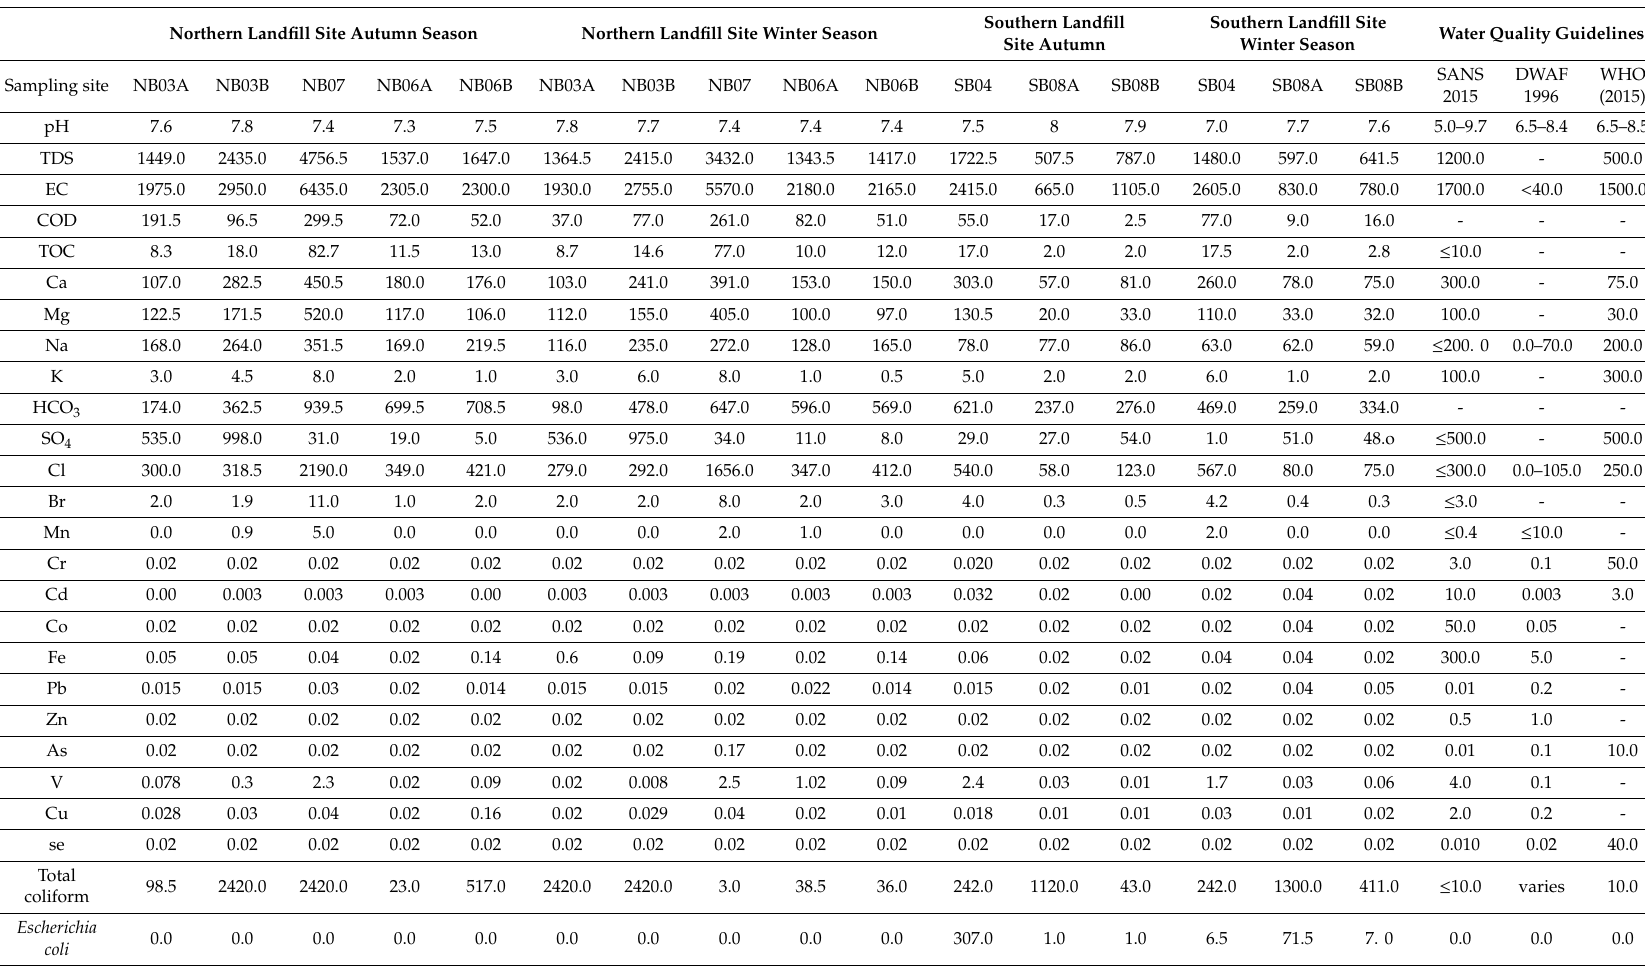
Table 1. Water quality parameters groundwater samples collected in the autumn and winter seasons from the northern and southern landfill